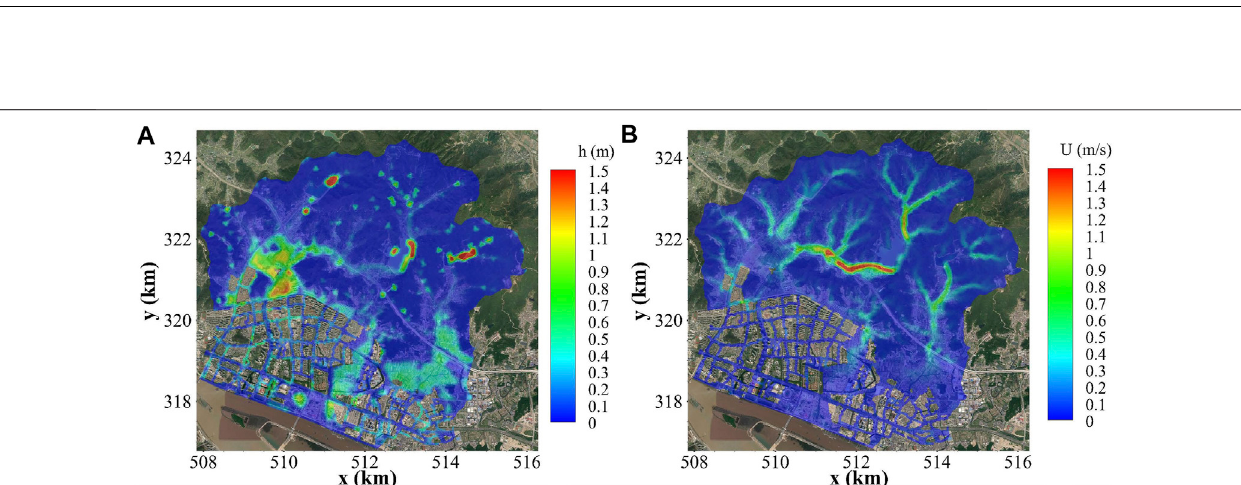
FIGURE 12 | (A) Water depth and (B) fl ow velocity at t (cid:2) 15 h for PSWM with in fi ltration in Case 3.